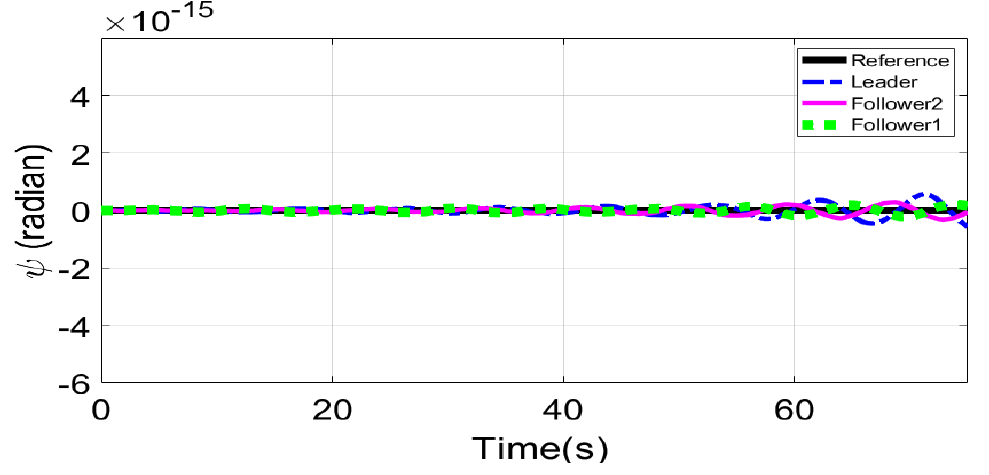
Figure 19. ψ tracking.